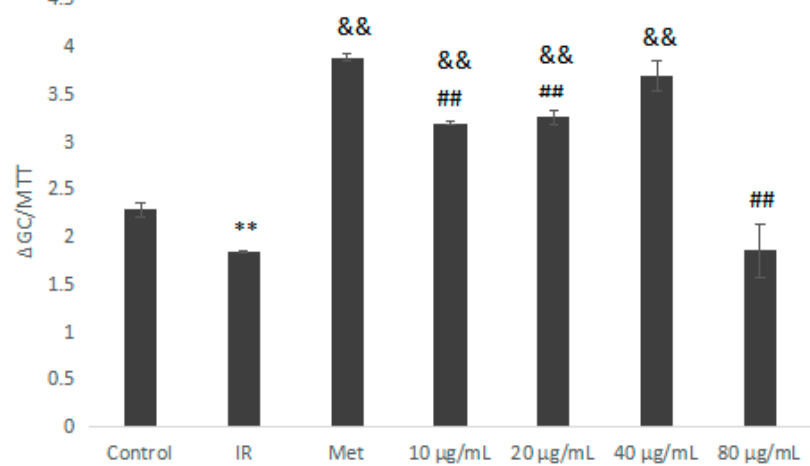
Figure 9. Effect of IOEP1 on the glucose consumption of insulin-resistance (IR) HepG2 cells. IR compared with the control, ** p < 0.01; compared with IR, && p < 0.01; compared with the Met group, ## p < 0.01.